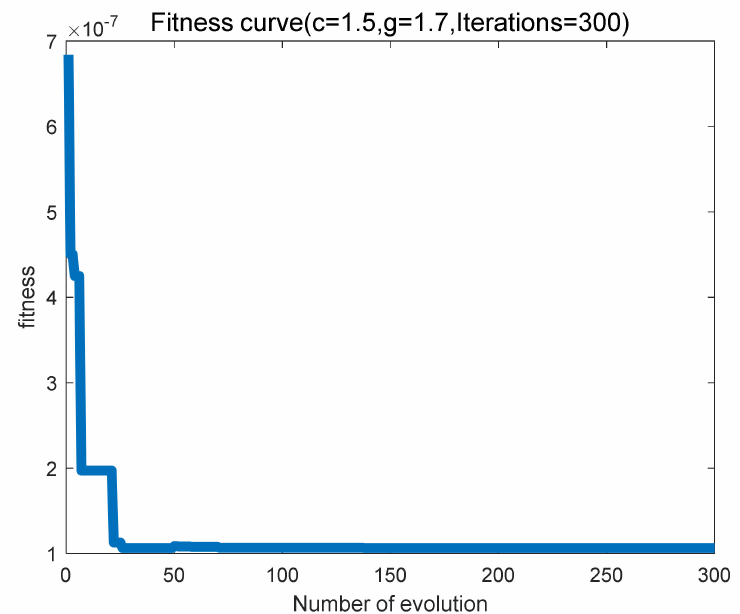
Figure 4. The iterative process of the PSO model for the N16 early warning